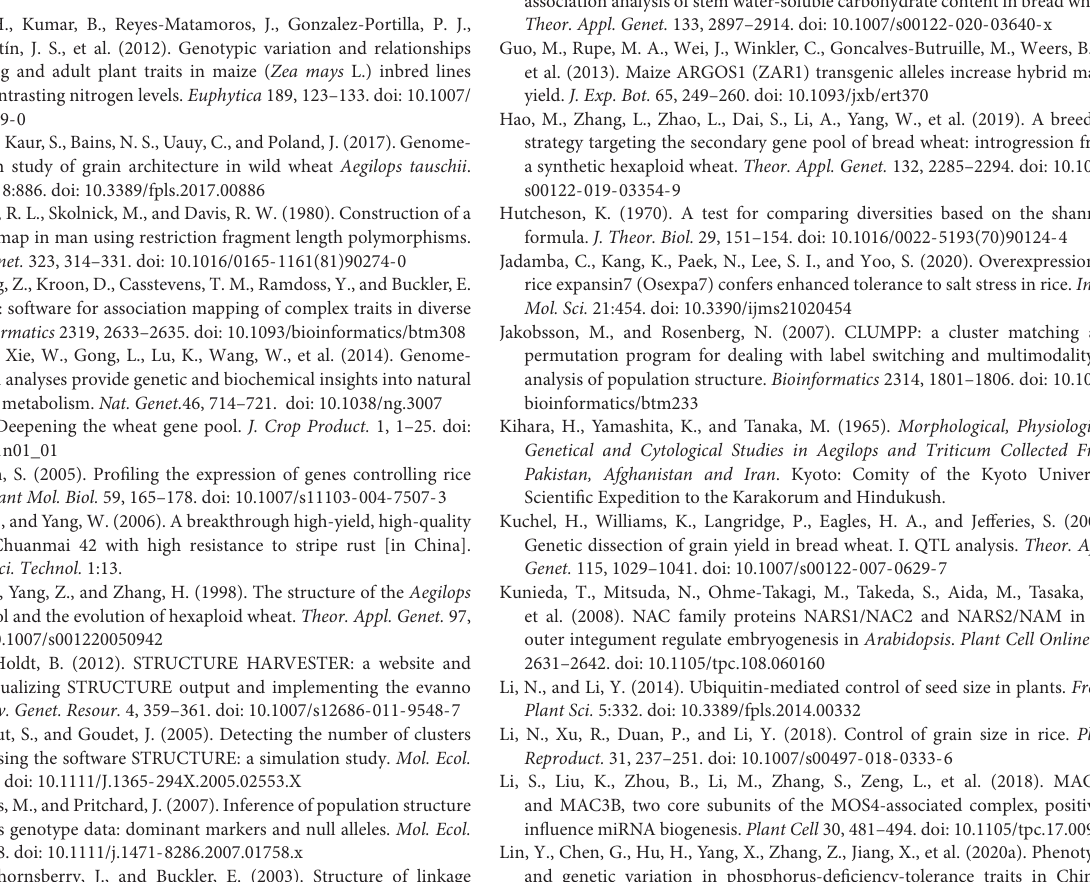
for kernel traits. Supplementary Table 7 | Genes Homologous annotation using KOBAS 3.0. Supplementary Table 8 | The six kernel traits measured in multiple